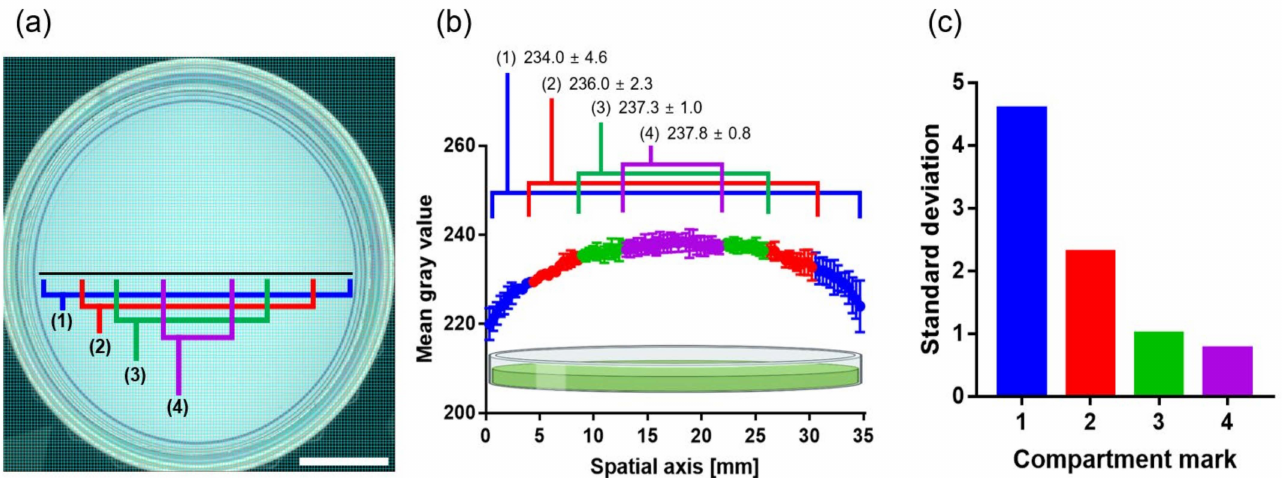
Figure 4. ( a ) Image of PNHC with compartment marks to investigate the thickness variation of the PNHC across the dish. Scale bar represents 1 cm. ( b ) Mean gray values with standard deviation corresponding to compartment mark 1–4 are co-plotted along the spatial axis (35 mm) ( n = 3). ( c ) Standard deviations of each compartment mark.